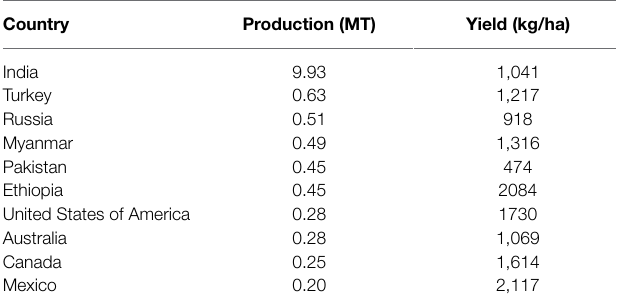
TABLE 1 | Global chickpea production and mean grain yields in 2019 (FAOSTAT, 2020).